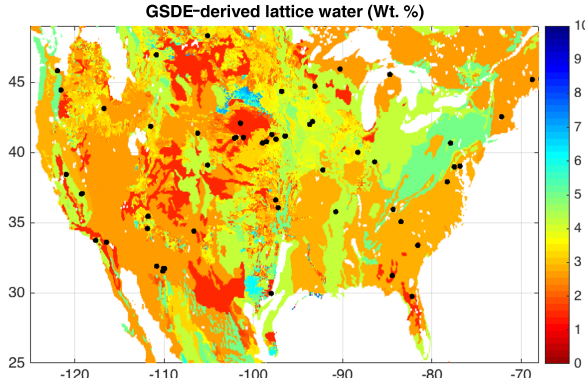
Figure 3. Derived 1km resolution lattice water weight percent map using the GSDE clay percent and regression analyses organized by soil taxonomic classification. See Table 1 for estimates of the mean, standard deviation, and linear regression vs. clay percent or- ganized by taxonomic group. Black dots indicate 61 locations where we have in situ composite/average samples for soil bulk density, soil lattice water, soil organic carbon, and clay weight fraction col- lected over a 12.6ha circle and averaged over the top 30cm (Ta- ble S1). Missing areas indicate surface water bodies or soil taxo- nomic groups with no or limited in situ lattice water sampling (see Table 1).